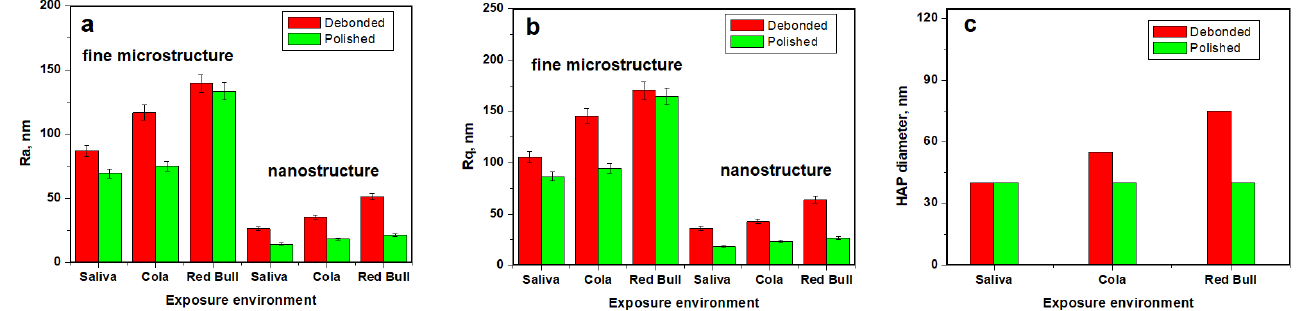
Figure 6. The evolution of surface parameters measured with AFM for RMGIC samples: ( a ) Ra,( b ) Rq, and ( c ) nano HAP diameter.